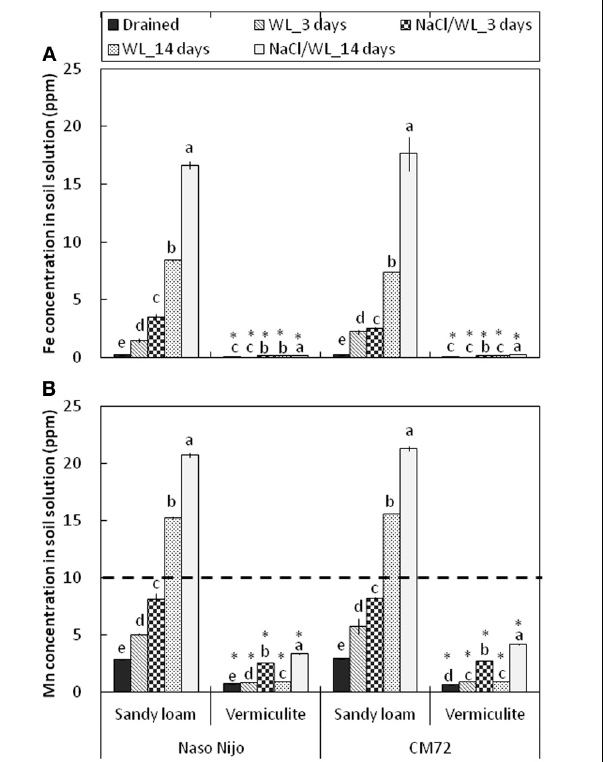
FIGURE 12 | Concentrations of Fe (A) and Mn (B) in the soil solution in pots subjected to waterlogging (submerged; no NaCl) and combined salinity and waterlogging (submerged in 200mM NaCl solution). Soil samples were taken on days 3 and 14 since commencement of treatment and compared with those taken from control treatment. Mean ± SD ( n = 5). Different lower case letters indicate the significant difference within the soil type at P < 0 . 01. Asterisk indicates the significant differences between sandy loam and vermiculite within variety at P < 0 .